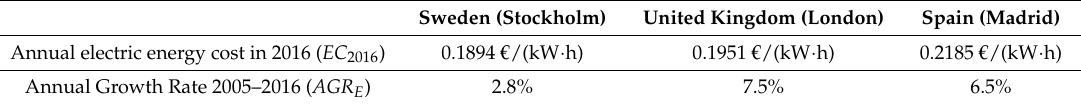
Table 4. Annual electric cost and its annual growth rate (AGR) in Sweden, United Kingdom and